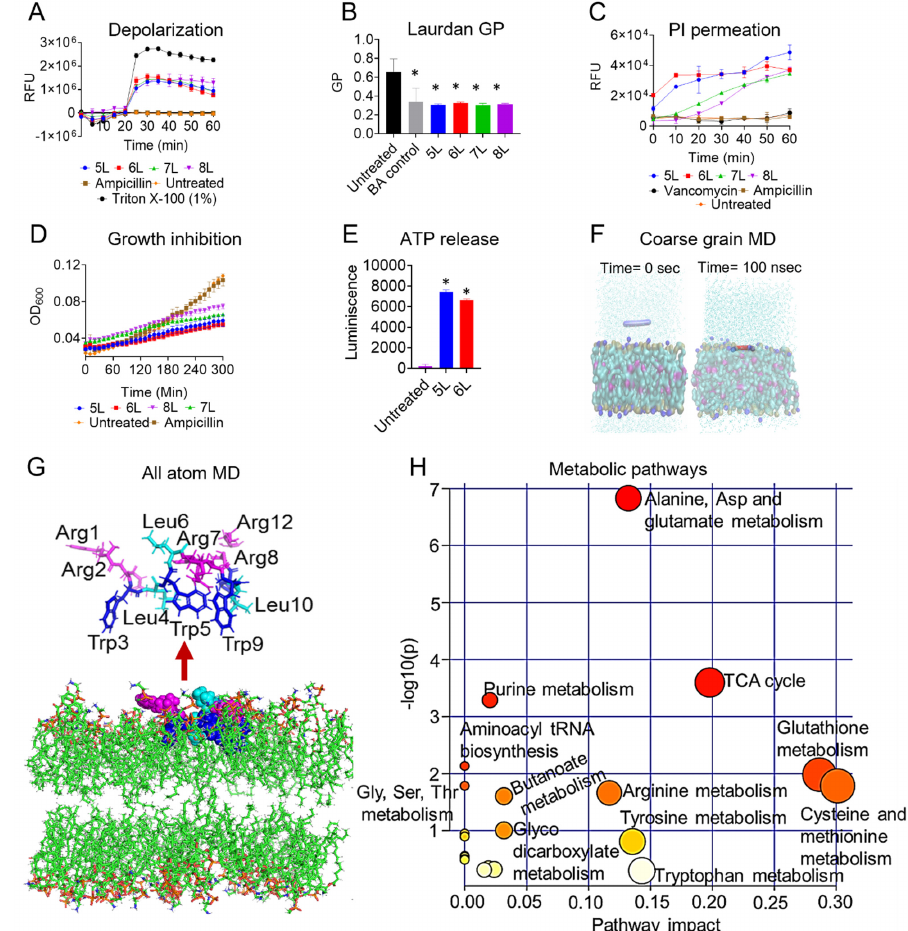
Figure 2. A plausible mechanism of action of LfcinB6-derived peptides. ( A ) DIBAC4(3) assisted E. faecium strain C68 membrane depolarization caused by peptides 5L–8L at 16 µg/mL. ( B ) Laurdan- based generalized polarization assessment by peptides at 32 µg/mL (significant, * p < 0.05, deter- mined by one way ANOVA). ( C ) PI permeation and ( D ) growth inhibition by 5L–8L peptides at 32 µg/mL. ( E ) ATP leakage of E. faecium strain C68 by peptide 5L and 6L at 32 µg/mL (significant, * p < 0.05, determined by one way ANOVA). ( F ) Snapshot of coarse grain MD simulation of peptide 5L in the presence of POPC: cardiolipin (3:1) membrane mimetic model showing complete peptide in- sertion at 100 ns. ( G ) All atom dynamics of peptide 5L showing a non-helical and amphipathic dis- tribution of amino acids (magenta: arginine; blue: tryptophan; and cyan: leucine). ( H ) Pathway anal- ysis of the targeted metabolome of E. faecium strain C68 treated with peptide 5L at 2× MIC.